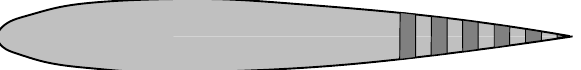
Figure 7. Schematitazion of the section of the rotor